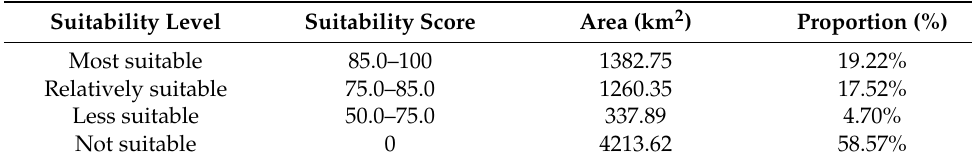
Table 2. Land suitability for urban-rural construction in the study